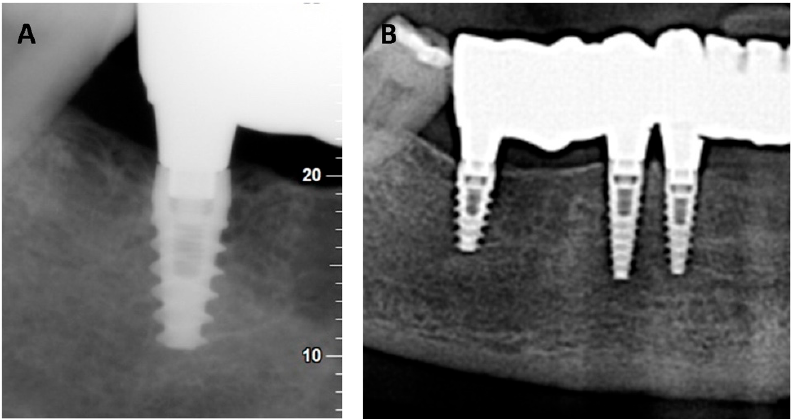
Figure 8. Periapical X-ray of a titanium implant with a ceramic composite abutment ( A ) and detail of the panoramic view ( B ).